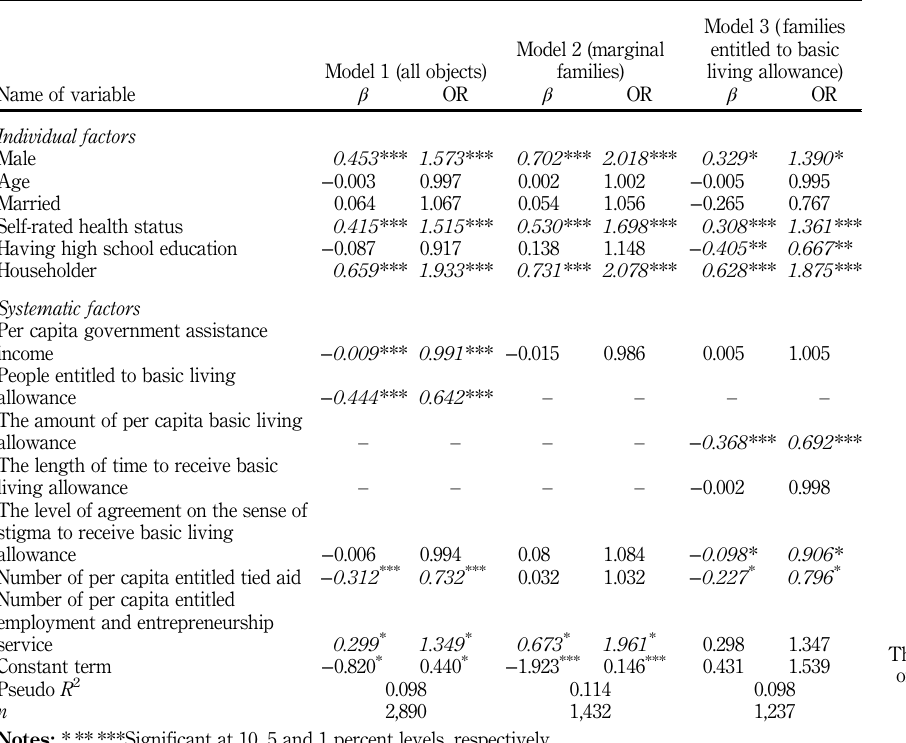
Table V. The regression